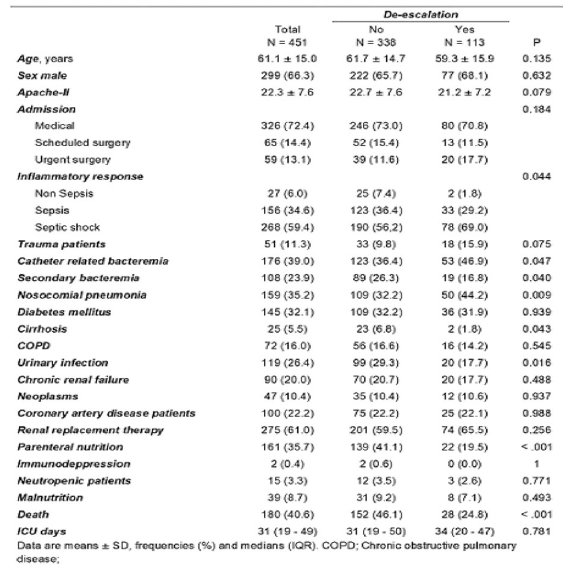
Table 2 (abstract 001052). Multivariate logistic analysis of Septic Shock Table 1 (abstract 001068). Characteristics of the patients according De-escalation